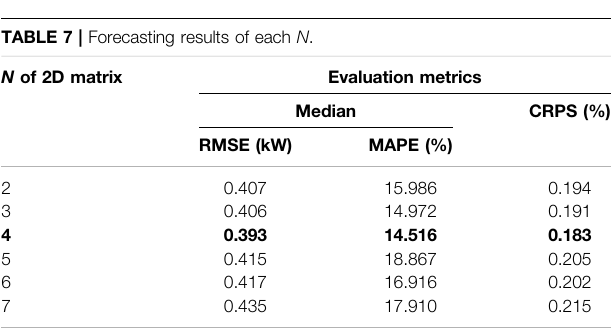
TABLE 7 | Forecasting results of each N